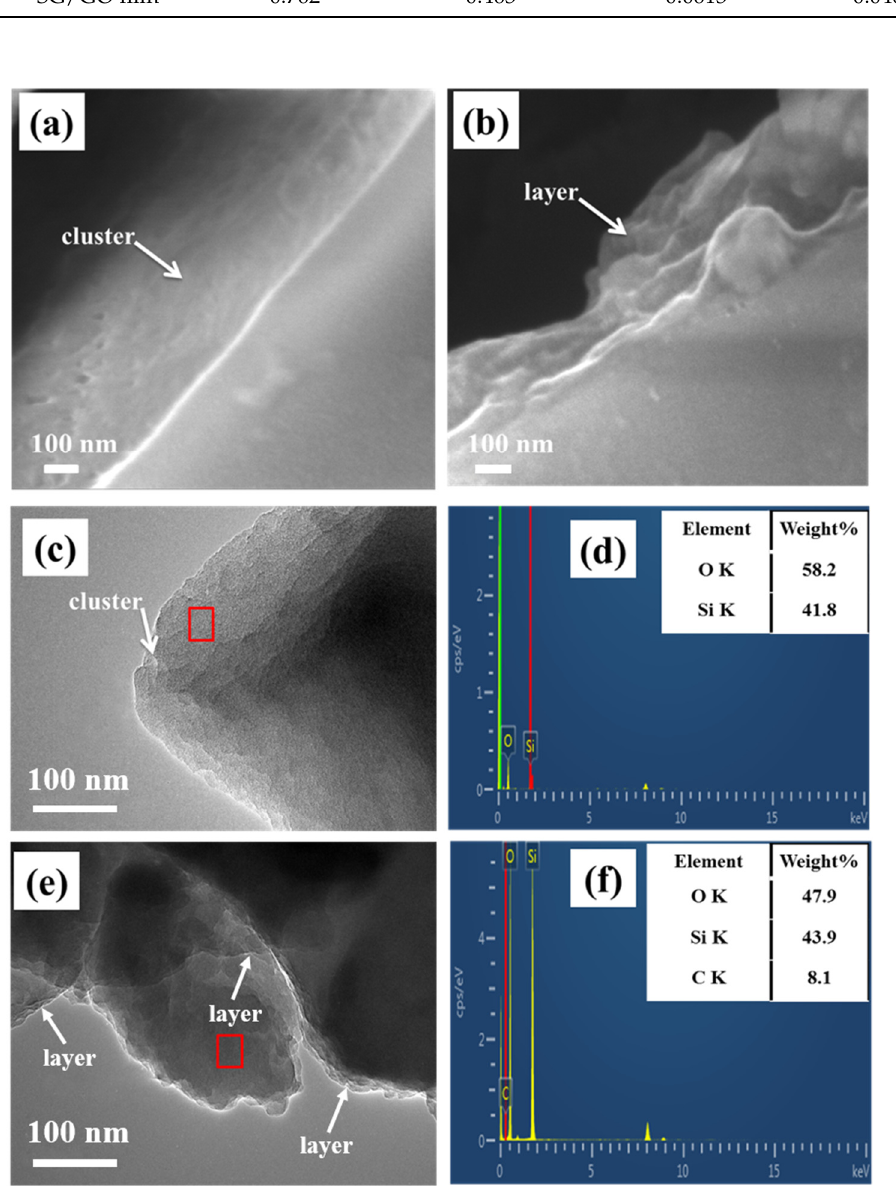
Figure 2. ( a ) SEM image of SG film, ( b ) SEM image of SG/GO film, ( c ) TEM image and ( d ) EDX spectrum of SG film, ( e ) TEM image and ( f ) EDX spectrum of SG/GO film. spectrum of SG film, ( e ) TEM image and ( f ) EDX spectrum of SG/GO